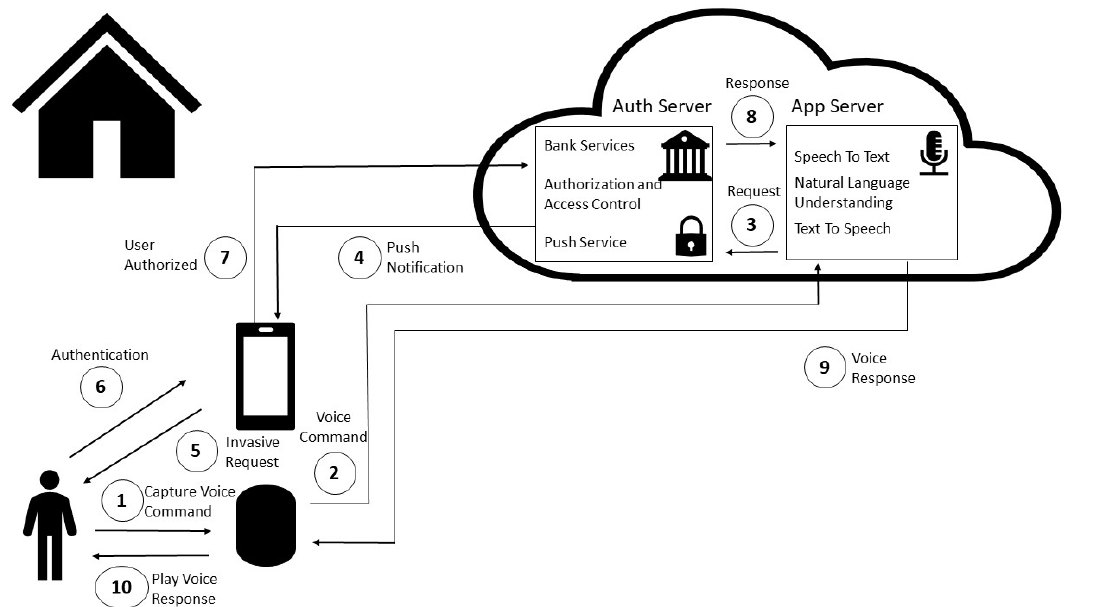
Figure 1. Closed Smart Speaker Architecture with Invasive Authorization based on push notification for user authentication through